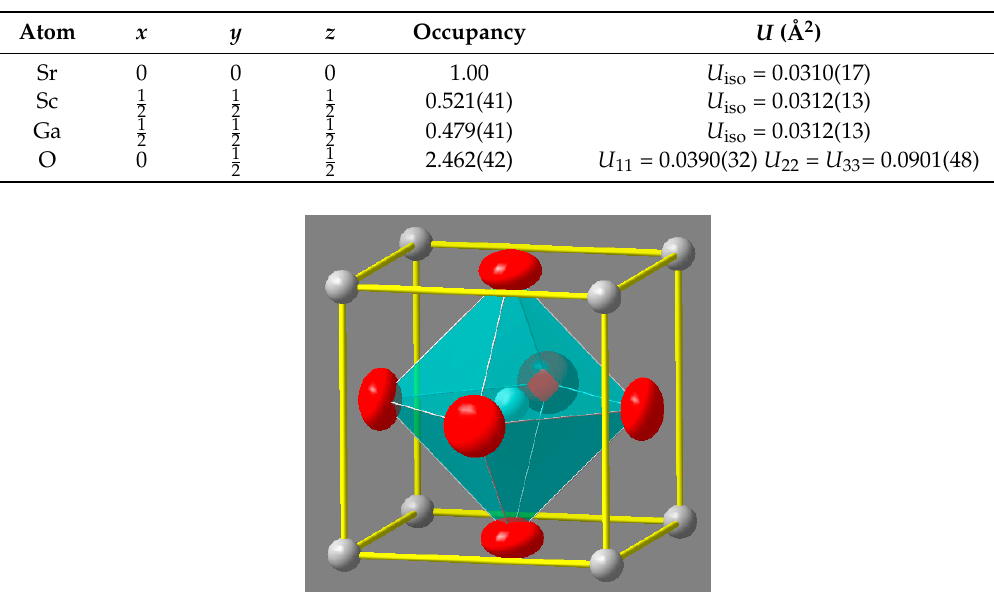
Table 2. c-SSGO structure data obtained from single crystal neutron diffraction data, collected on diffractometer 5C2@LLB with λ = 0.83 Å, installed at the hot source of the ORPHEE reactor. Refinements were carried out in space group Pm-3m with unit cell parameter a = 3.9932 Å (determined from X-ray powder diffraction (XRPD), CuK α 1 ). One hundred and fifty two measured reflections